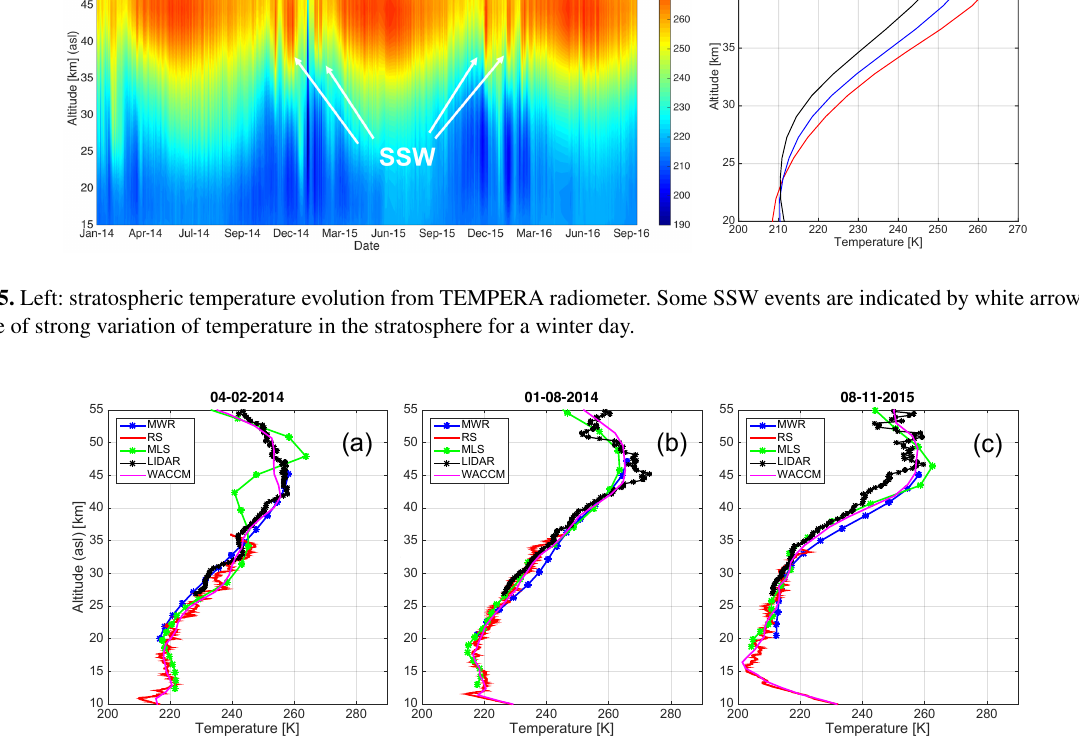
Figure 6. Stratospheric temperature profiles for night-time measurements from TEMPERA, RS, MLS, lidar and WACCM model